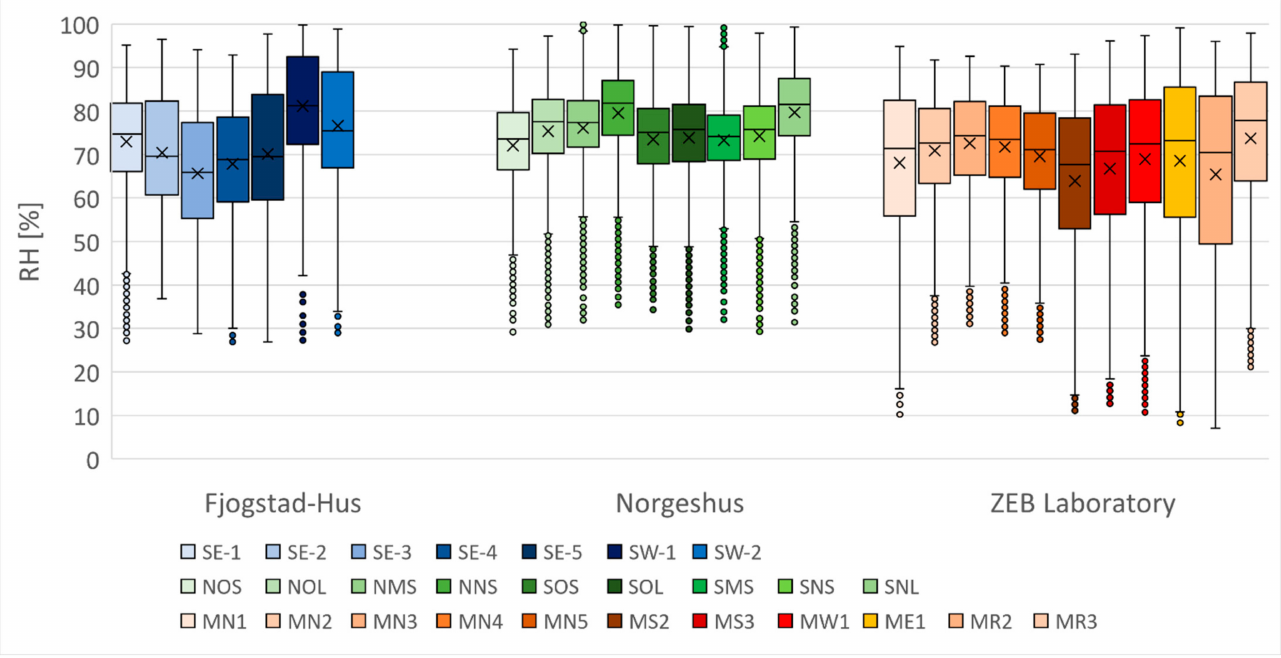
Figure 9. The measured cavity air relative humidity (RH) for the three case buildings. Correlation values between pairs of sensors that belong to the same group, or are otherwise related, are presented in Table 4. There is a generally high correlation between data series in the same positions. The outlier in the MN (ZEB Laboratory north façade) series is MN1, which is located high up on the wall. Compared to the rest of the sensors, it has lower correlation with the data from other sensors and with the exterior air temperature. The same can be seen for MR2 and MS2, located near the top of the roof and the south wall,